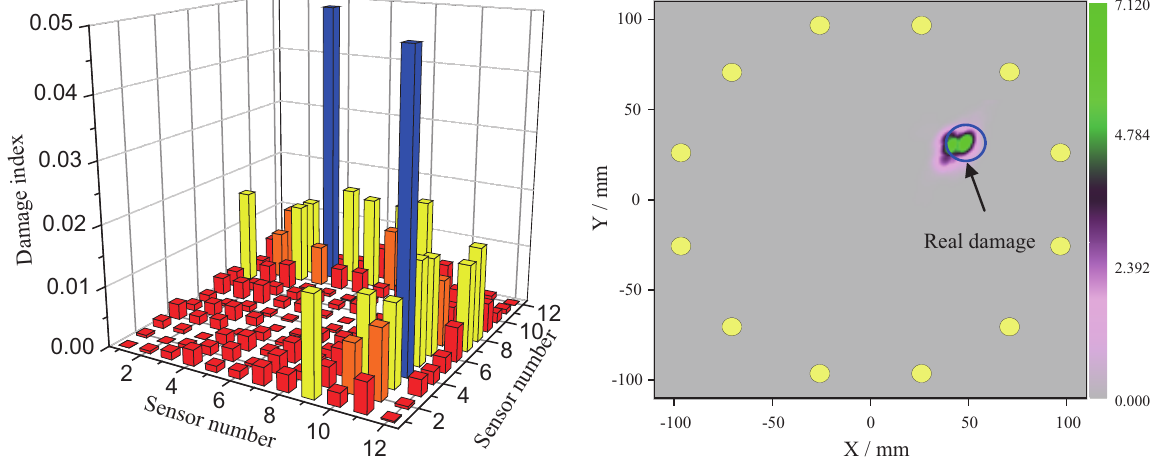
Fig. 12. Damage image for the stiffened composite panel.